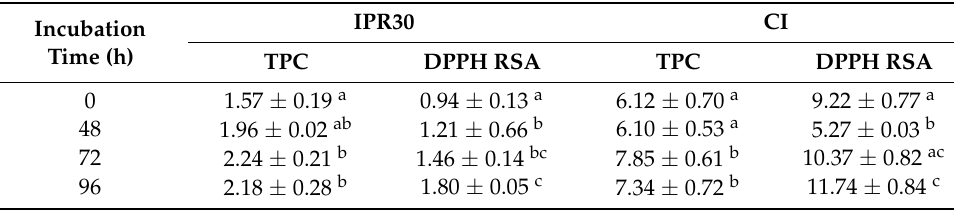
Table 1. Total phenolic content (TPC) and DPPH radical scavenging activity (RSA) of RB.